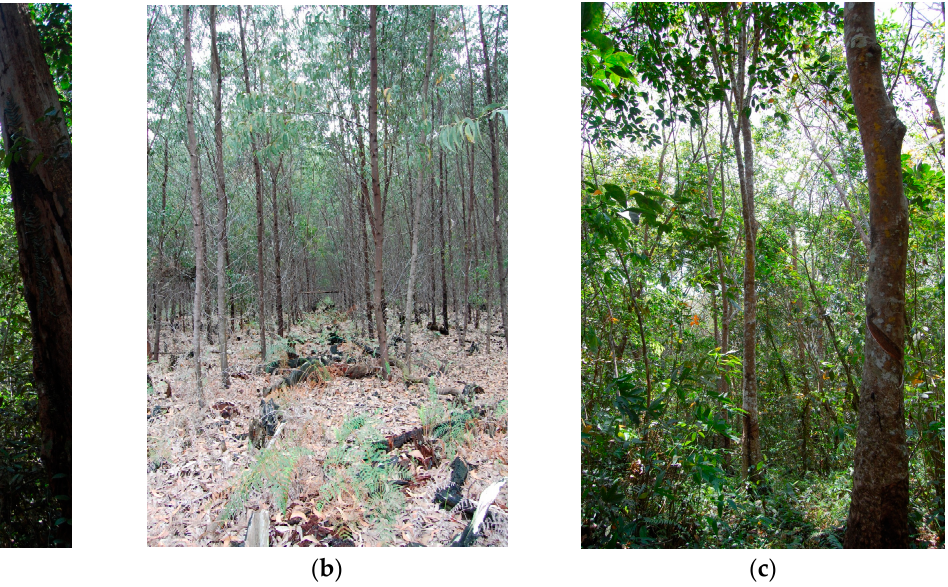
Figure 1. ( a ) Location of the study site (indicated by a small black square) in Sumatra, Indonesia. ( b ) Location of survey transects: natural peat swamp forests (NPF) shown by circles, planted acacia forests (PAF) by triangles, and jungle rubber forests (JRF) by rectangles. Bukit Batu Wildlife Reserve is shown in a rectangle along the Bukit Batu River. Acacia plantations are shown in the area with diagonal lines, where logging operation is permitted and managed by plantation companies named PT Bukit Batu Hutani Alam and PT Sakato Paratama Makmuri.